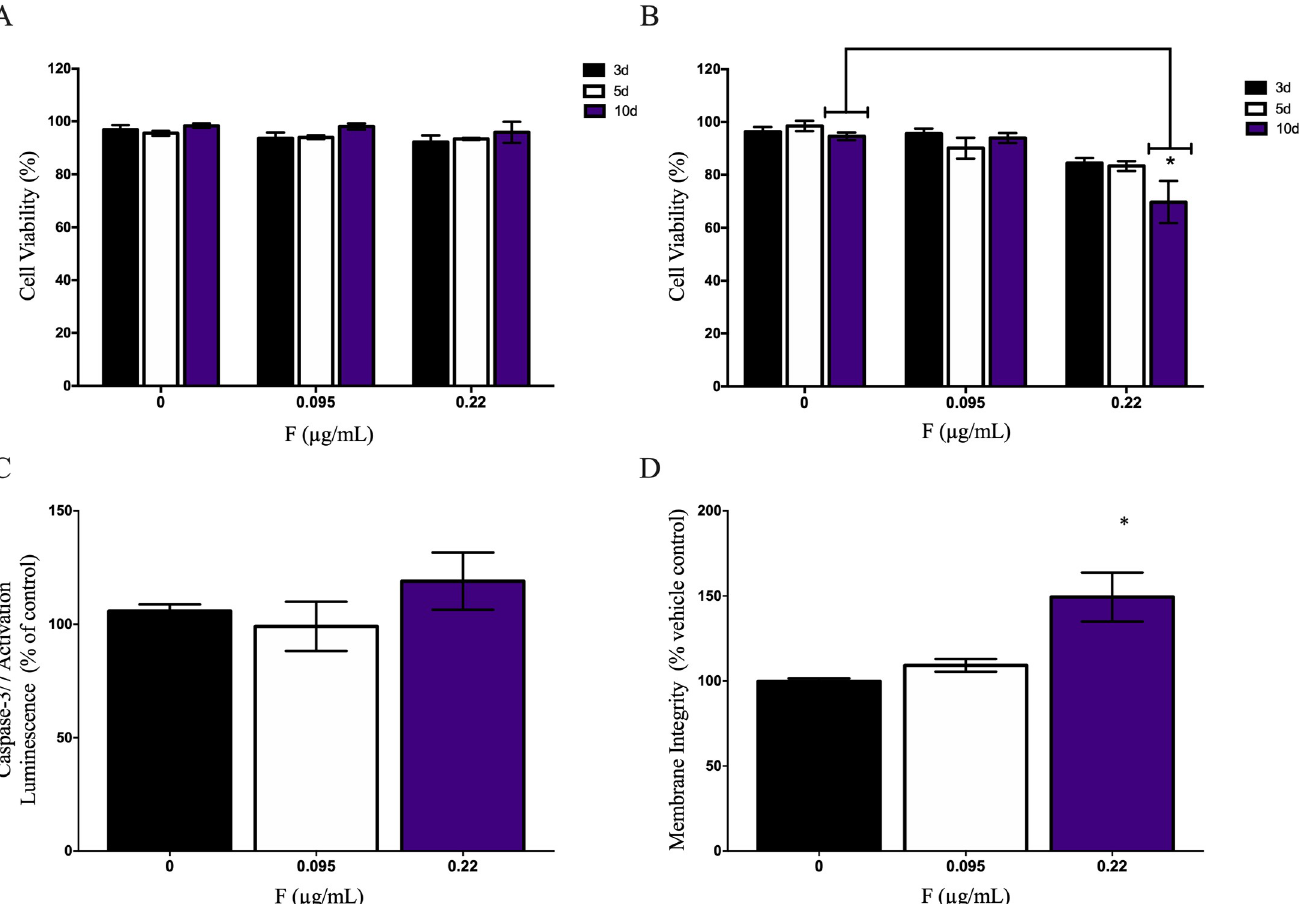
Fig 2. Fluoride toxicity on central nervous system human cells. Cell viability was performed on A) IMR-32 and B) U87 in different time and F concentrations. Live and dead cells were counted after 3, 5 and 10 days of F exposure. U87 cell death apoptosis or necrosis were evaluated after 10 days of 0.22 μ g/mL F by C) 3/7 caspase assay and D) membrane integrity analysis respectively. Data were expressed as mean ± SD. Statistical analysis were performed by one-way ANOVA followed by Tukey’s test. Statistical significance compared to control group were showed by � when p < 0.05.